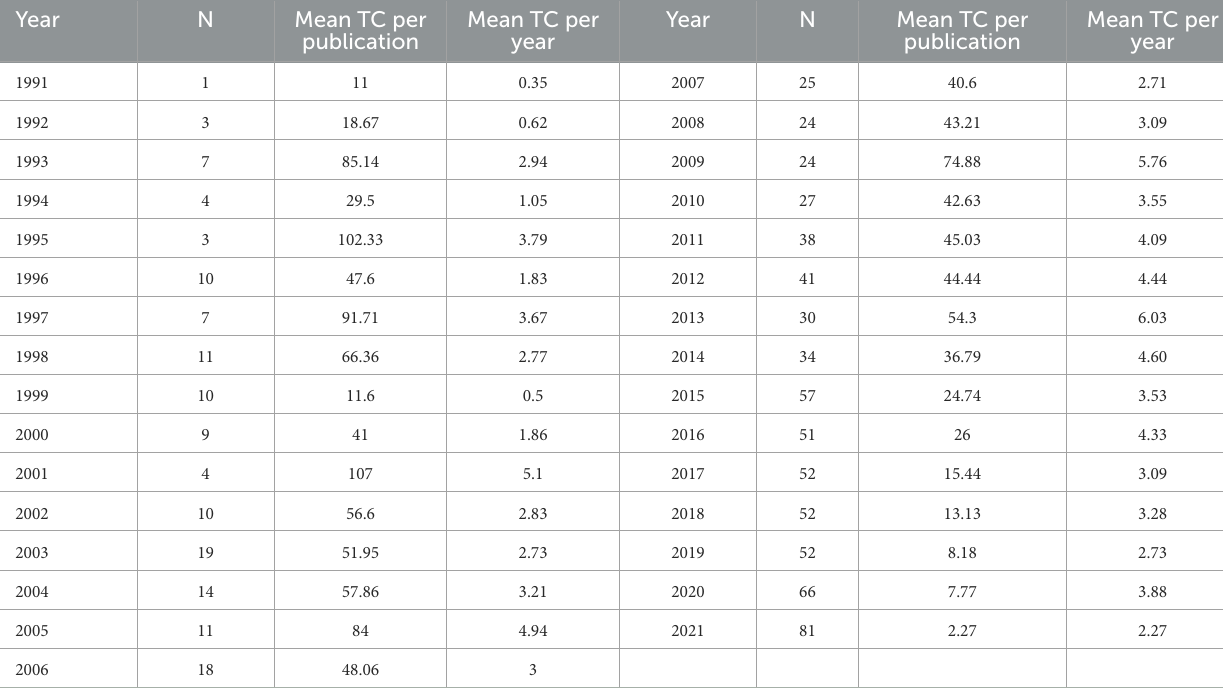
TABLE 1 The number of publications and citations from